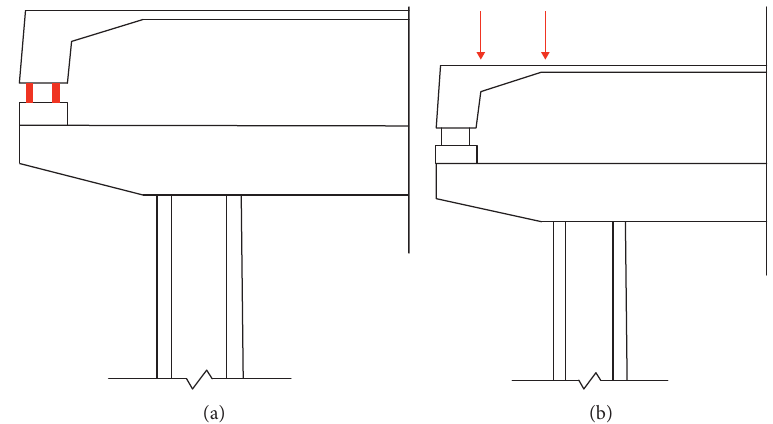
Figure 6: Sketches for repair scheme 2: (a) 1 st level repair (emergency rescue); (b) 2 nd level repair (bearings